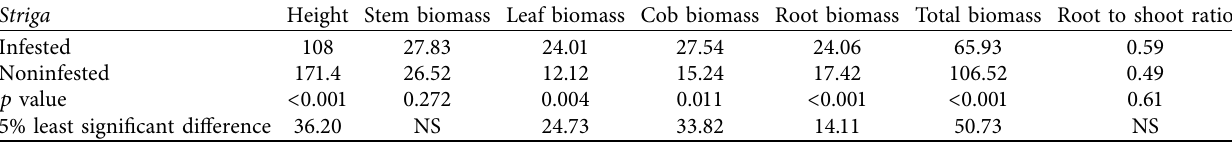
Table 3: Comparison of Striga asiatica main effects (infested and noninfested). Striga